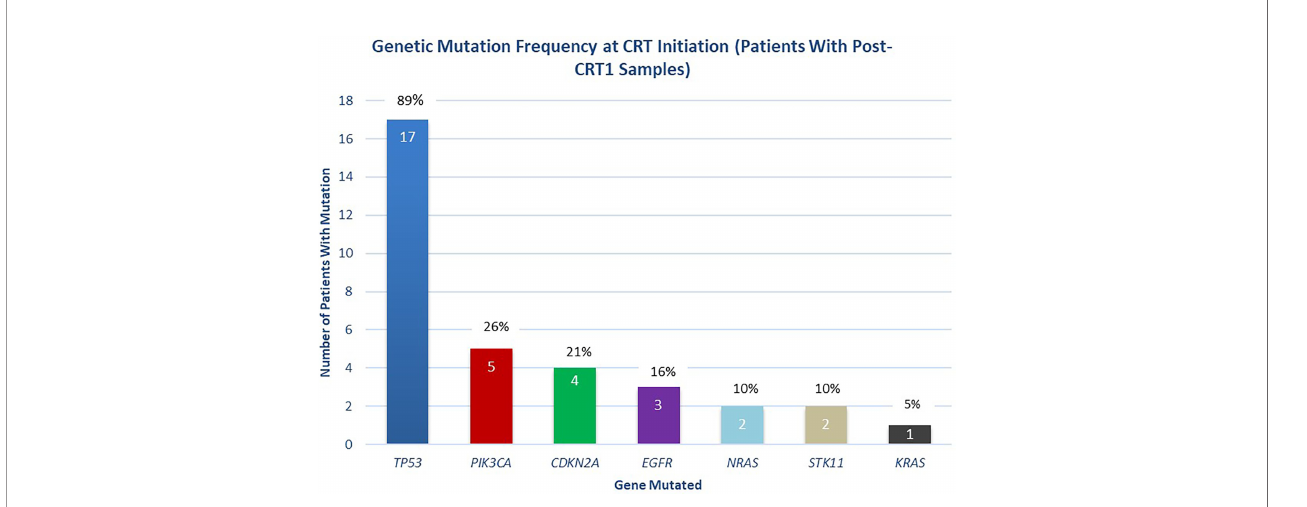
FIGURE 3 | Distribution of Mutations Detected at Initiation of Chemoradiotherapy. Distribution of mutations detected at the initiation of chemoradiotherapy (pre-CRT), in patients with post-CRT1 samples collected (n = 19 patients).